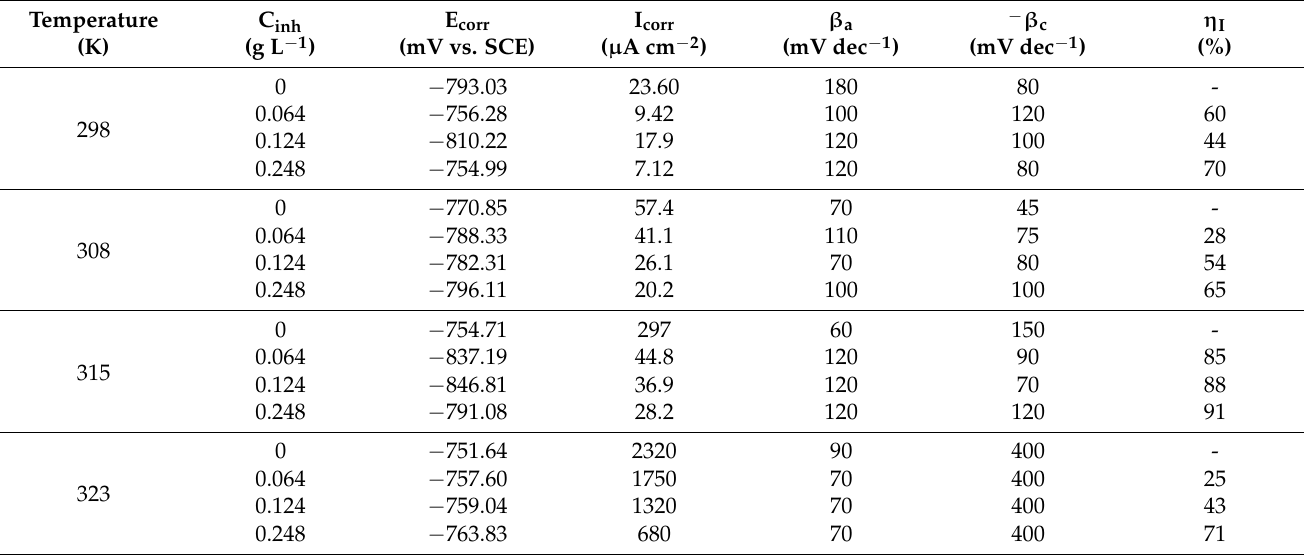
Table 3. Electrochemical parameters obtained from the Tafel curves for aluminum corrosion in HCl 0.1 M in the presence and in the absence of Ilex paraguariensis at different concentrations and working